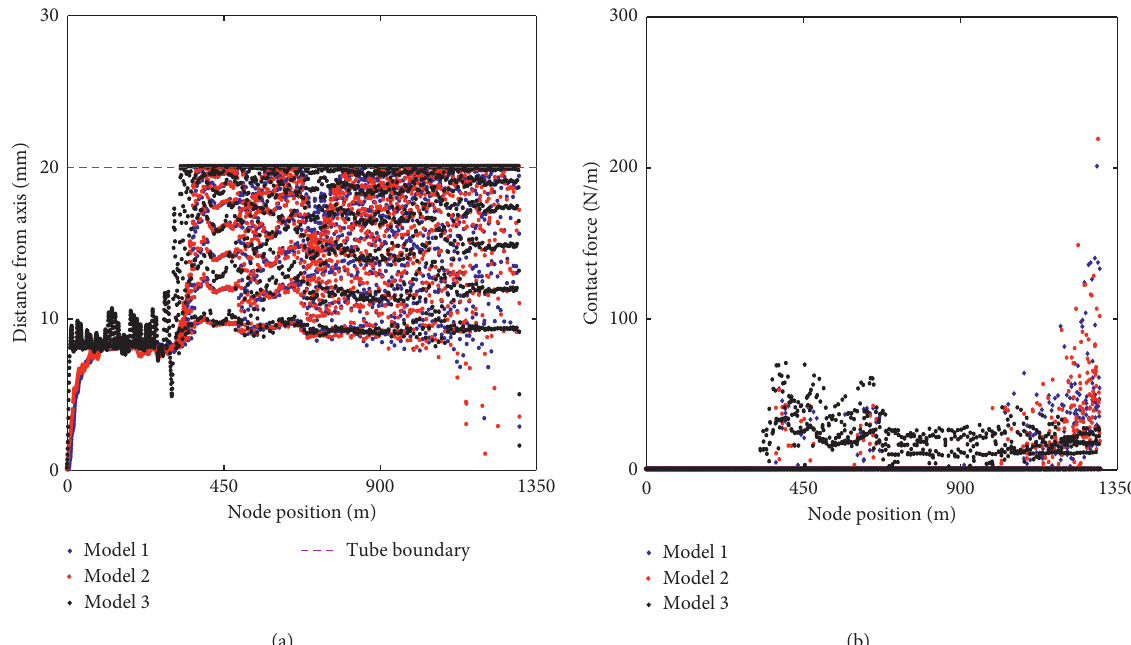
Figure 9: The rod node simulation results at 9 s. (a) Distance between node position and borehole axis. (b) Contact force between the rod and tube.